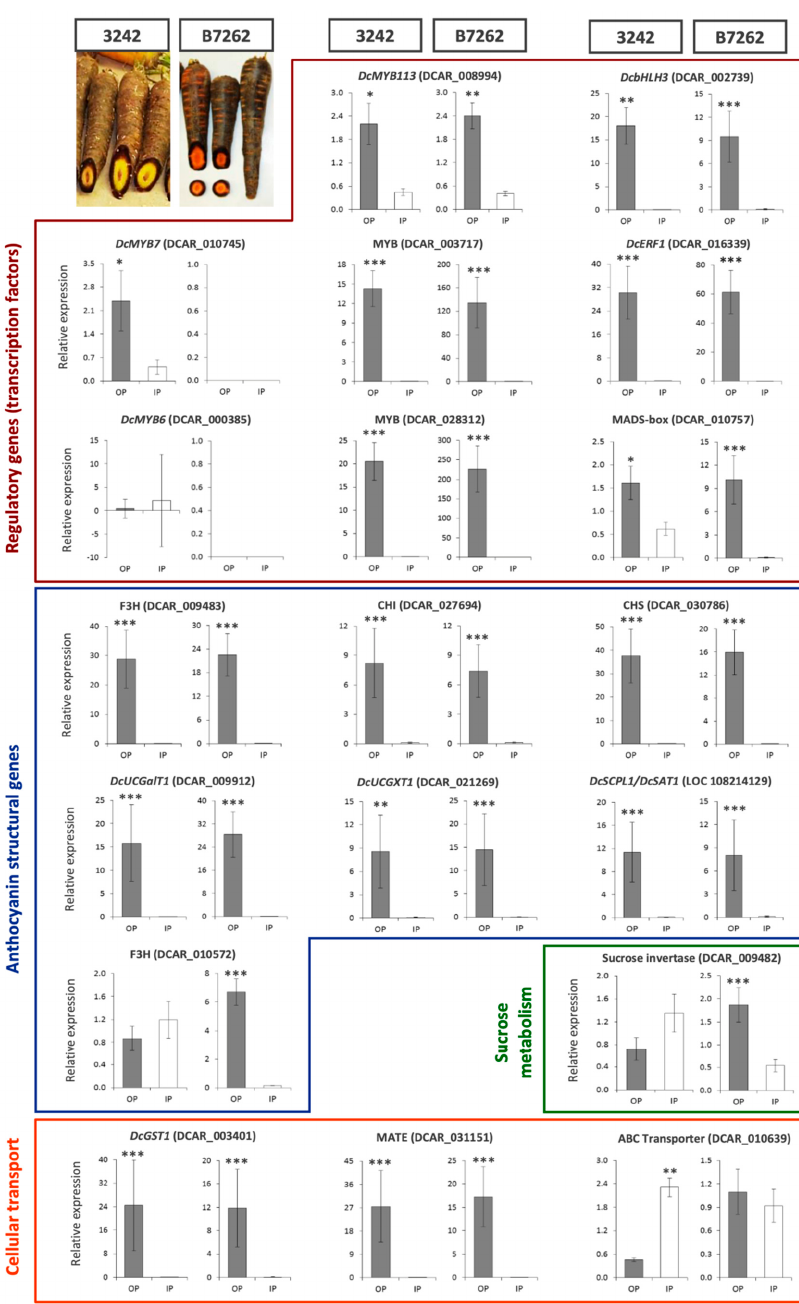
Figure 2. Comparative analysis of transcript levels by RT ‐ qPCR for 19 selected genes in purple outer phloem (OP) (gray bars) vs. non ‐ purple inner phloem (IP) (white bars) tissues from roots of 3242 and B7262 genetic backgrounds. For 3242, roots from a derivative F 3 family of 3242 ‐ F 2 (used for mapping and transcriptomic analyses) were used. Root phenotypes for both genetic backgrounds are shown in the upper-left images. The selected anthocyanin-related genes were consistently differentially expressed in all of the POP vs. NPIP transcriptome comparisons (16 genes), and/or they colocalized with ROPAP and RIPAP in the linkage map, and/or they were previously reported to be involved in the biosynthesis, modification or transport of anthocyanins. Bars indicate mean values for the fold change in gene expression relative to the expression of the internal control gene (actin), as calculated from the ratio ∆ Cq-target gene/ ∆ Cq-actin [34] and their standard errors. Asterisks indicate significantly higher gene expression at p < 0.05 (*), p < 0.01 (**), and p < 0.001